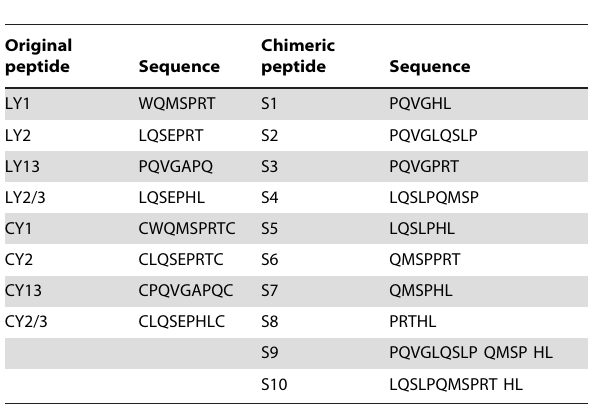
Table 2. Synthesized